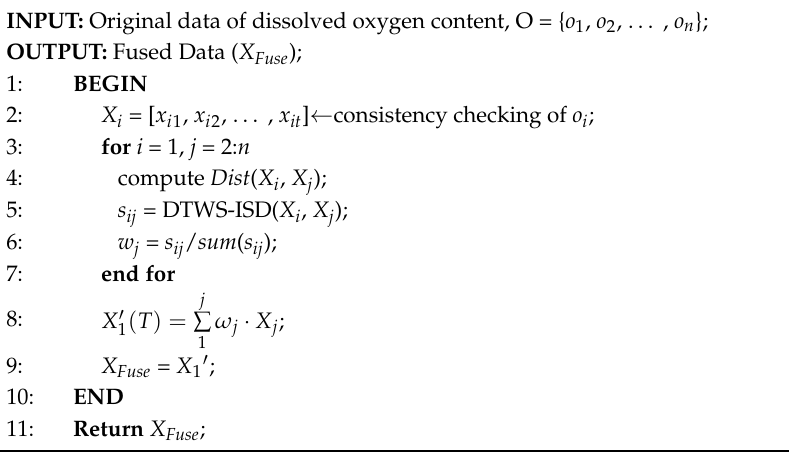
Algorithm 1. Data Correction